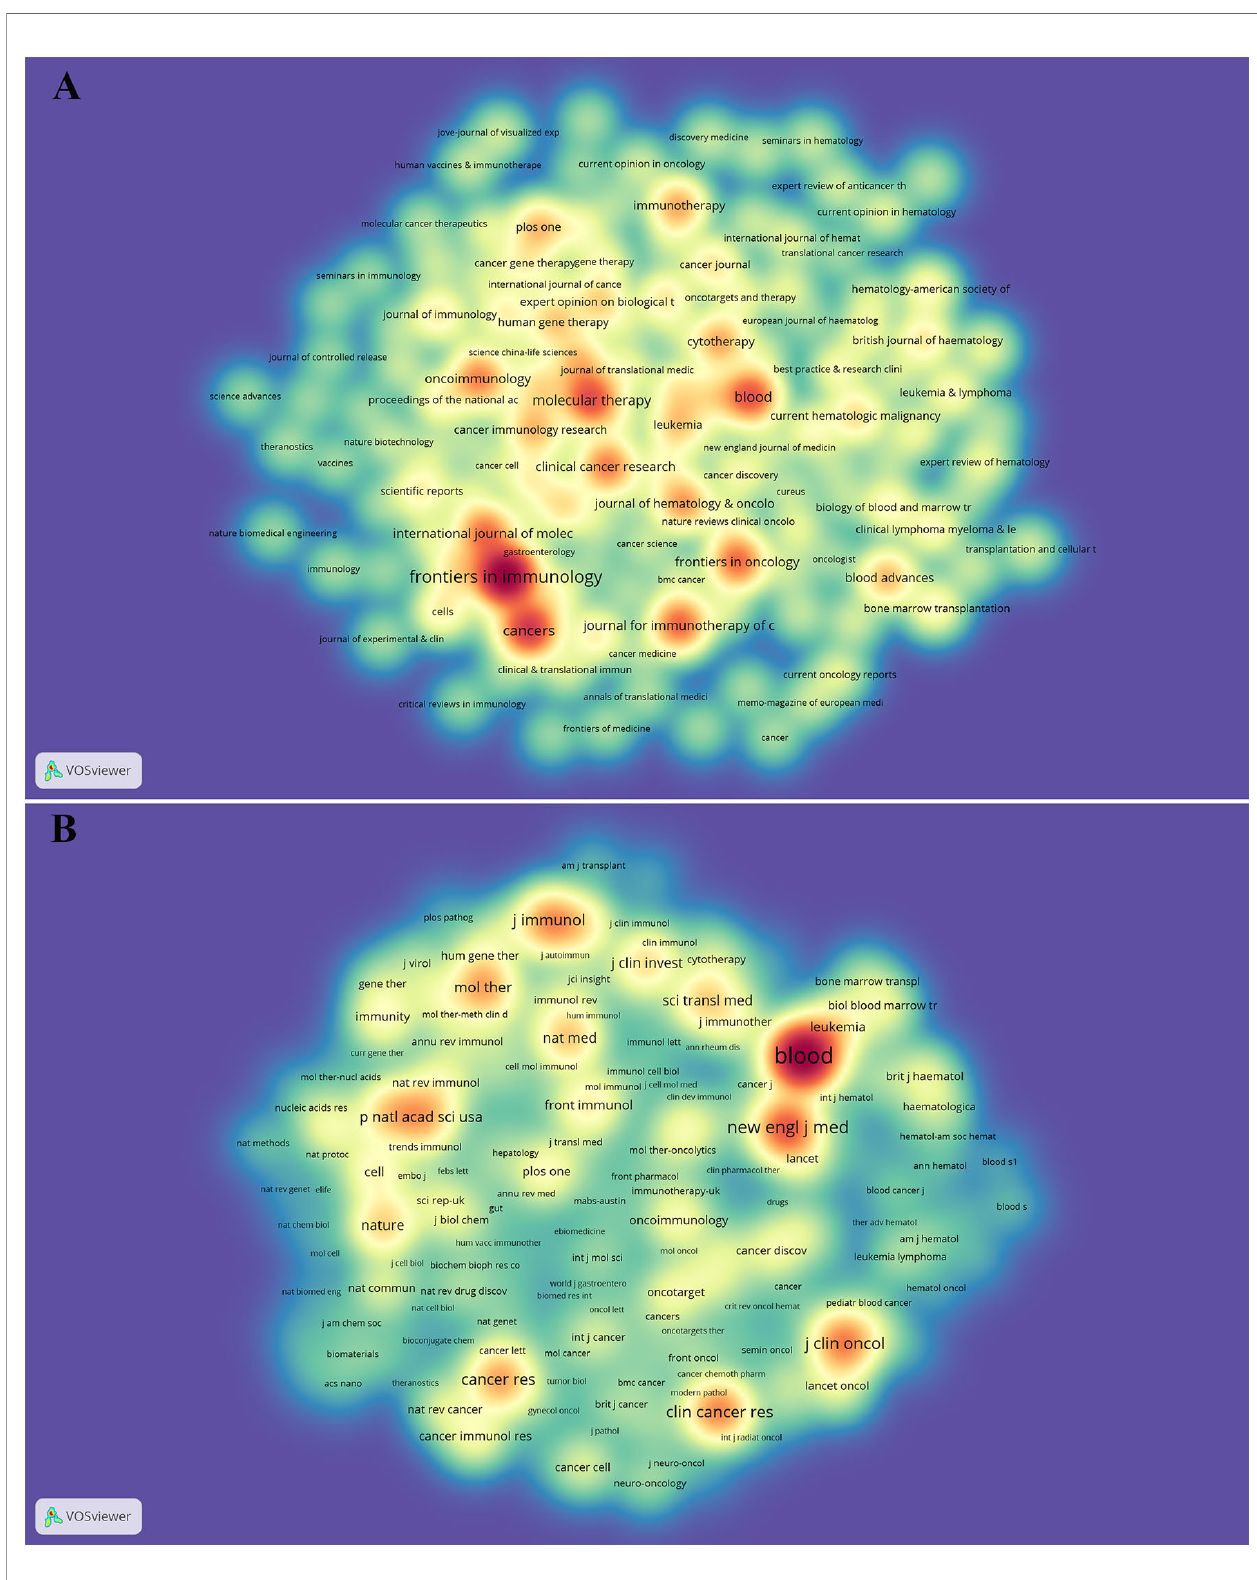
FIGURE 3 | The density map of journals (A) and co-cited journals (B) in CAR-T cell research. (A) shows journals with several publications ≥ 10; (B) shows the journals with citations ≥